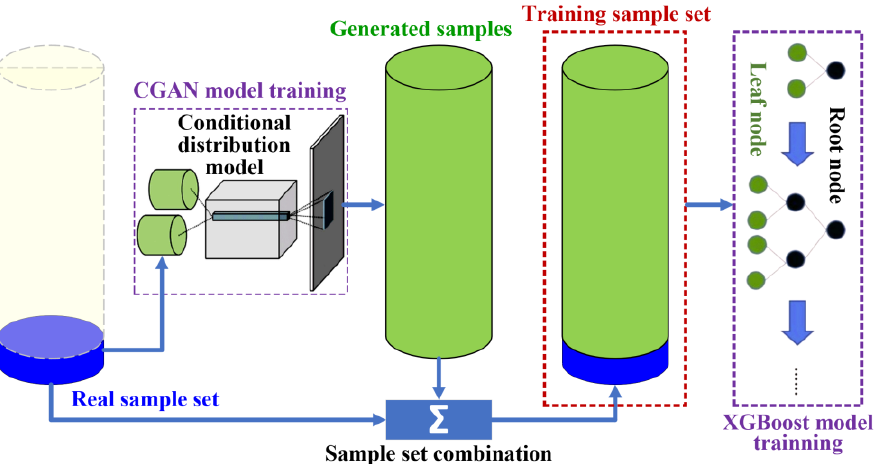
Figure 2. Structure diagram of CGAN-enhanced XGBoost method for fault prediction.